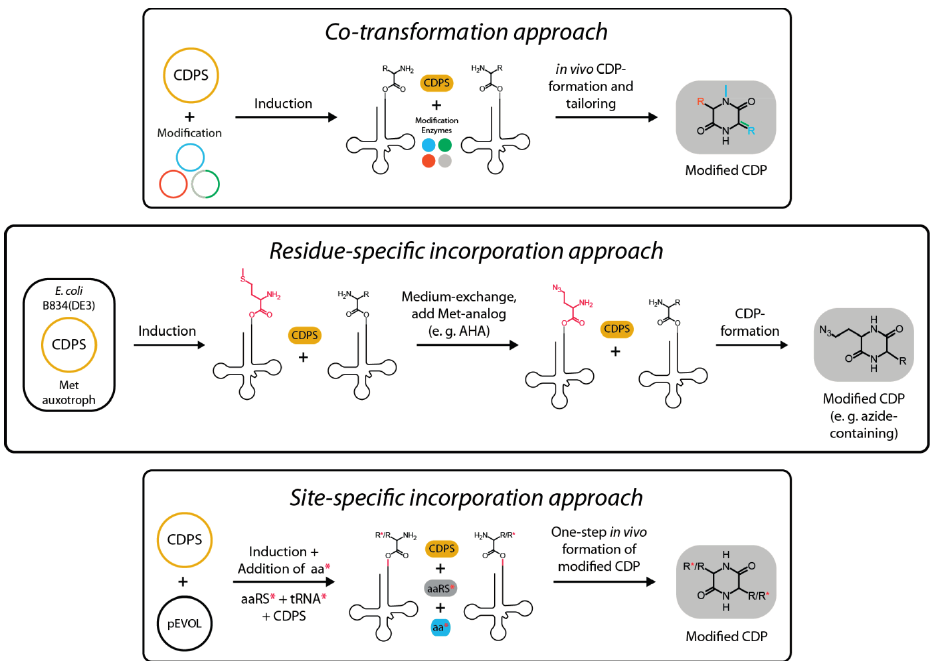
Figure 9. Different approaches for the rational generation of structural diversity using CDPSs. Shown are the co-transformation approach employing various modification enzymes to introduce new structural features into the CDP-scaffold, the residue-specific incorporation approach which relies on the use of amino acid analogs and auxotrophs and the site-specific incorporation approach where an orthogonal aaRS/tRNA pair is used to incorporate non-proteinogenic amino acids into